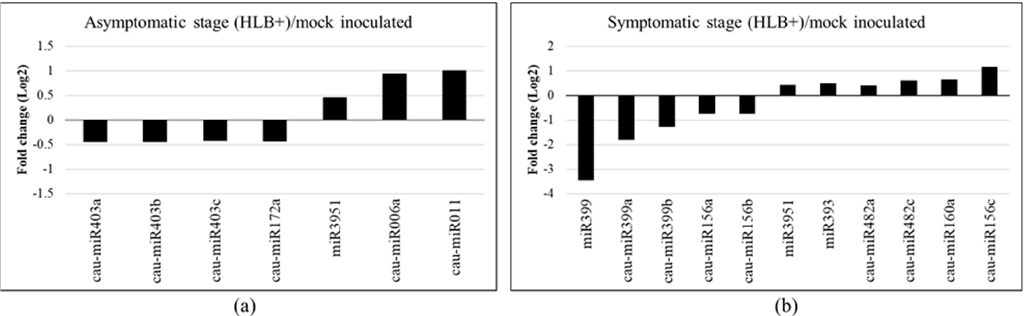
Figure 2. Differential expression of known and novel miRNAs in Citrus aurantifolia inoculated with Candidatus Liberibacter asiaticus ( C Las). ( a ) Asymptomatic (8 wpi) and ( b ) Symptomatic (16 wpi) stages of HLB disease. Bars represent fold change (Log 2 ) expression from HLB+/HLB − ratio of two biological replicates using read counts from ShortStack data.